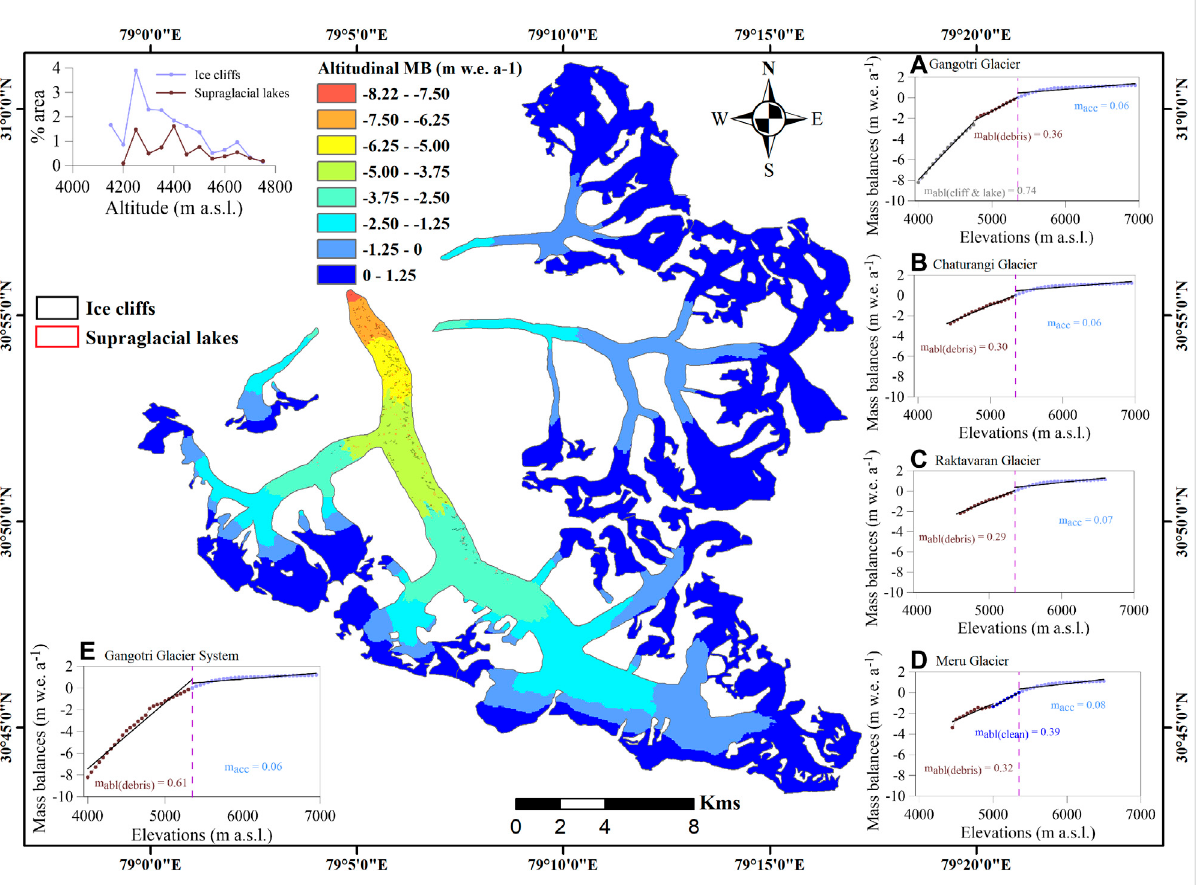
FIGURE 9 AltitudinalMBsandgradientvalues(inmw.e.per100 m)intheablationzone(m abl(cliff&lake) ,m abl(debris) andm abl(clean) forthethickdebrisablation zone having hotspots, debris cover ablation zone and clean ablation zone, respectively) and accumulation zone (m acc ) for (A) Gangotri Glacier, (B) Chaturangi Glacier, (C) Raktavaran Glacier, (D) Meru Glacier and (E) Gangotri Glacier System. Vertical dashed line represents the ELA of each